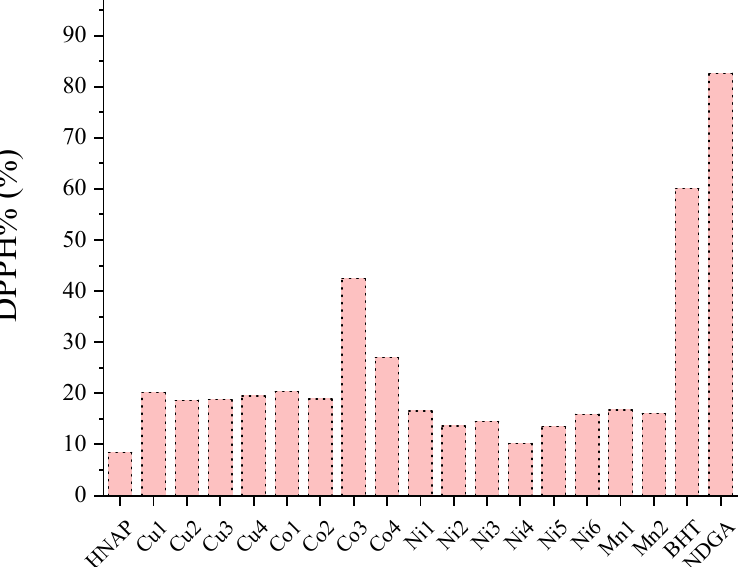
Figure 23. DPPH scavenging activity (DPPH%) of naproxen and its reported complexes after 20 min and 60 min incubation. (Codes of compounds: HNAP = naproxen; Ni1 = [Ni(NAP) 2 (CH 3 OH) 4 ]; Ni2 = [Ni(NAP) 2 (bipy)(CH 3 OH)]; Ni3 = [Ni(NAP) 2 (phen)(Η 2 Ο)]; Ni4 = [Ni(NAP) 2 (bipyam)]; Ni5 = [Ni(NAP) 2 (Hpko) 2 ]; Ni6 = [Ni(NAP) 2 (py) 2 (Η 2 Ο) 2 ]; Mn1 = [Mn(NAP) 2 (py) 2 (H 2 O) 2 ] and Mn2 = [Mn(NAP) 2 (phen)(H 2 O)].)